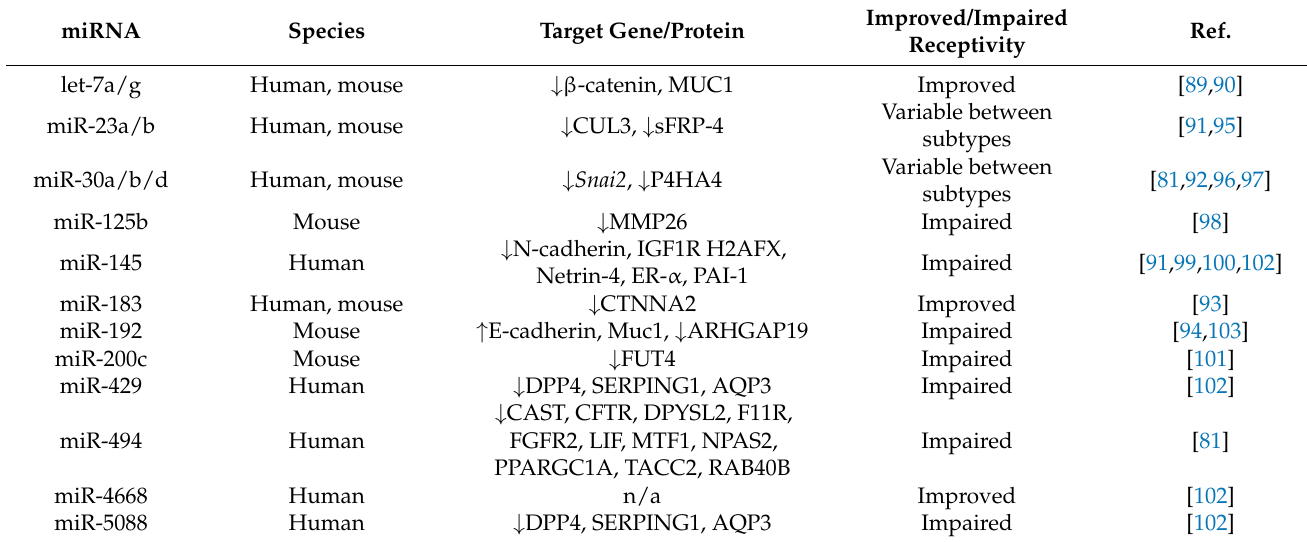
Table 2. The miRNAs identified in endometrial epithelial